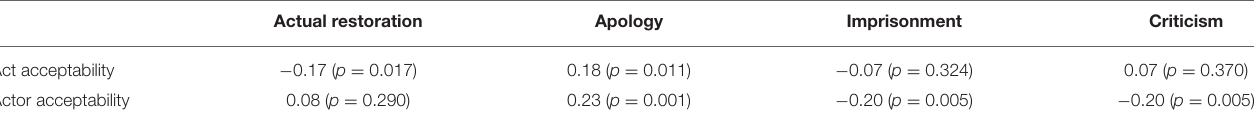
TABLE 3 | Correlations of acceptability and preference for the four